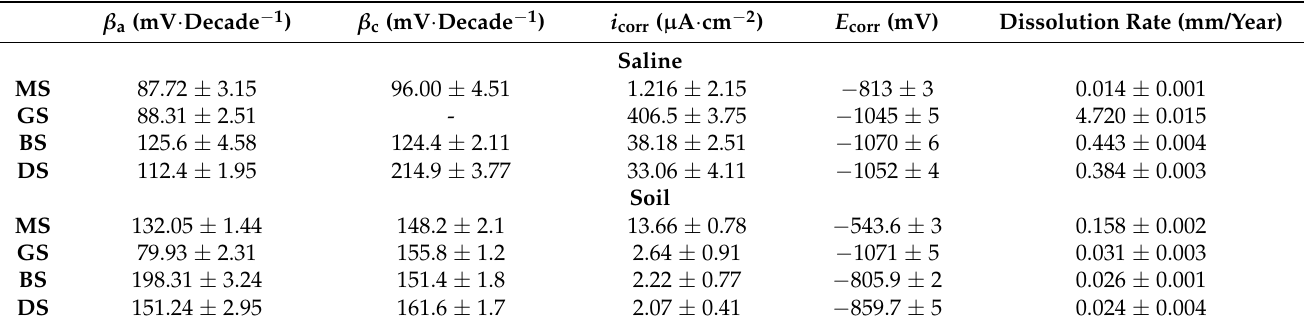
Table 3. Kinetic parameters of the MS, GS, and ZRCG coated samples exposed to saline and soil environments obtained from the polarization